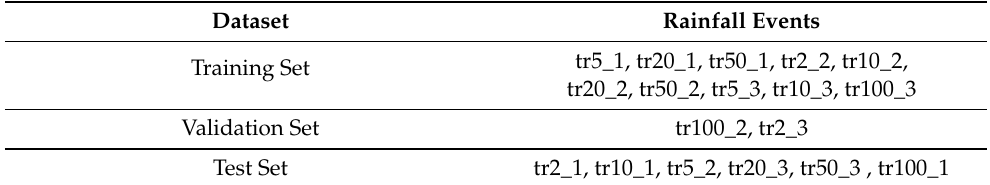
Table 2. Allocation of rainfall events for training, validation, and test sets. Dataset Rainfall